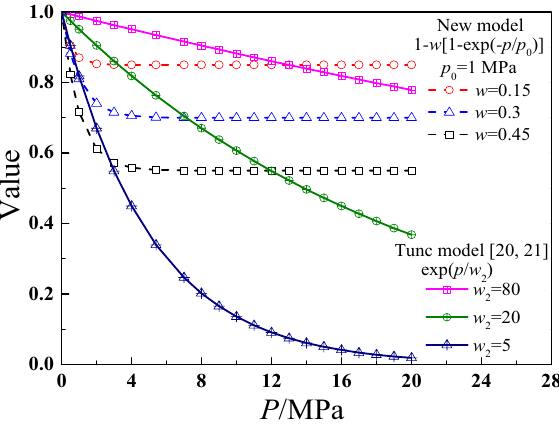
Figure 3. Comparisons of the two confining pressure effect